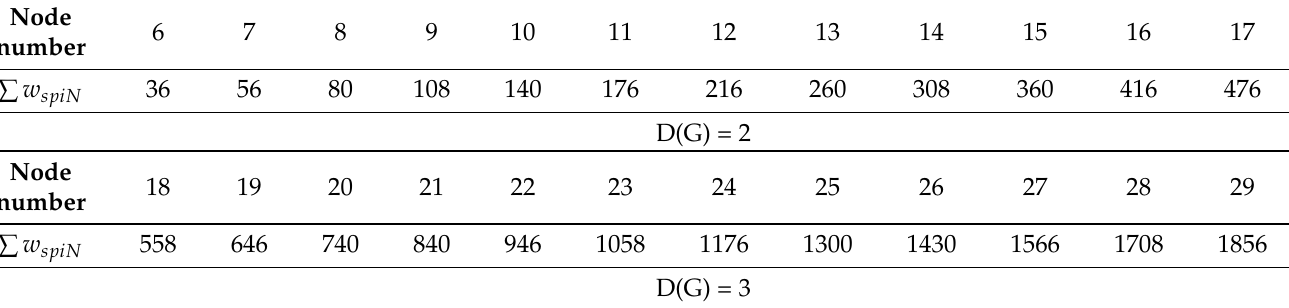
Table 15. Total values of the w spi coefficients for the fourth-degree